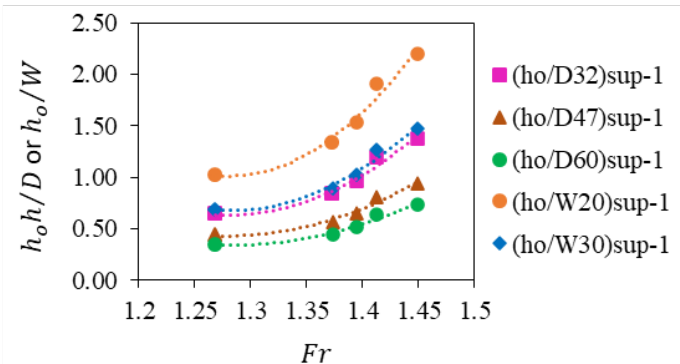
slight increase in water depth near the upstream face resulting from the bluntness of the emergent cylinder.